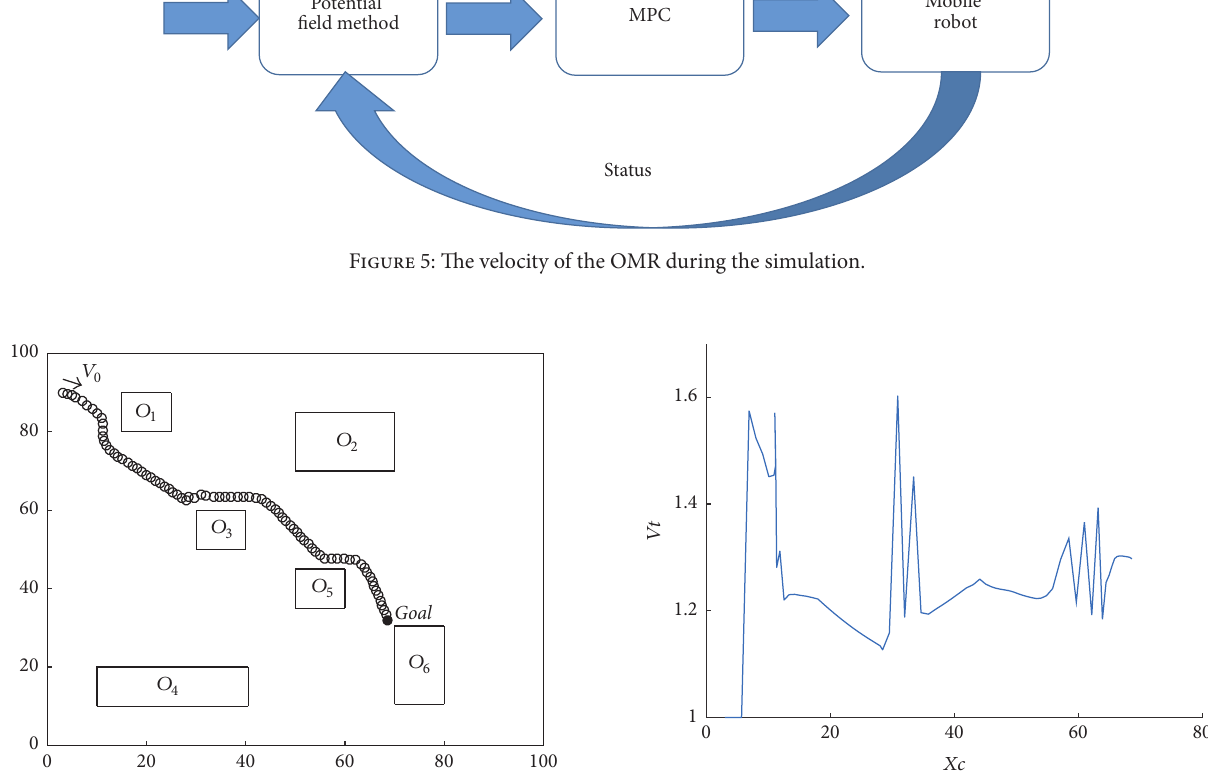
Figure 6: The simulation of OMR controlled by kinematic con- troller moving in the workplace.